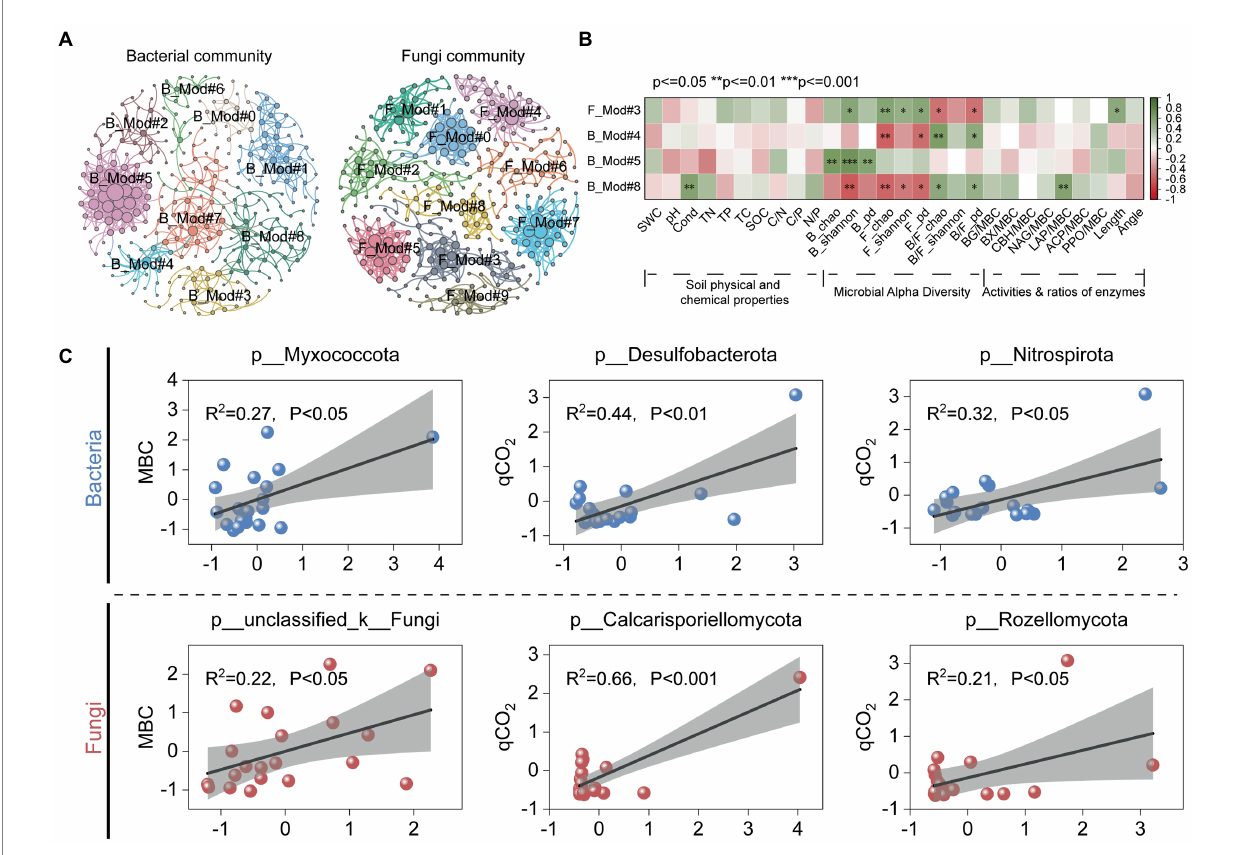
FIGURE 4 Division of main bacterial and fungal modules and correlation analysis with each index. (A) Diagram of network module division, where modules are divided by different colors, the left is bacterial community and the right is fungal community; (B) Spearman analysis between network modules and factors (physical–chemical properties, alpha diversity, and enzyme activities). (C) Linear fit of dominant species (including bacterial and fungal phylum levels) to microbial metabolism efficiency. * p < 0.05, ** p < 0.01, *** p < 0.001.